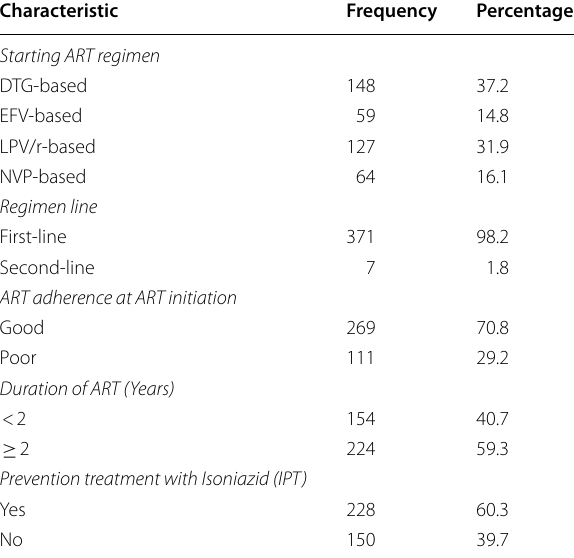
Table 3 Drug regimen characteristics of HIV-positive children and adolescents on ART in Tabora region, from January 2018 to